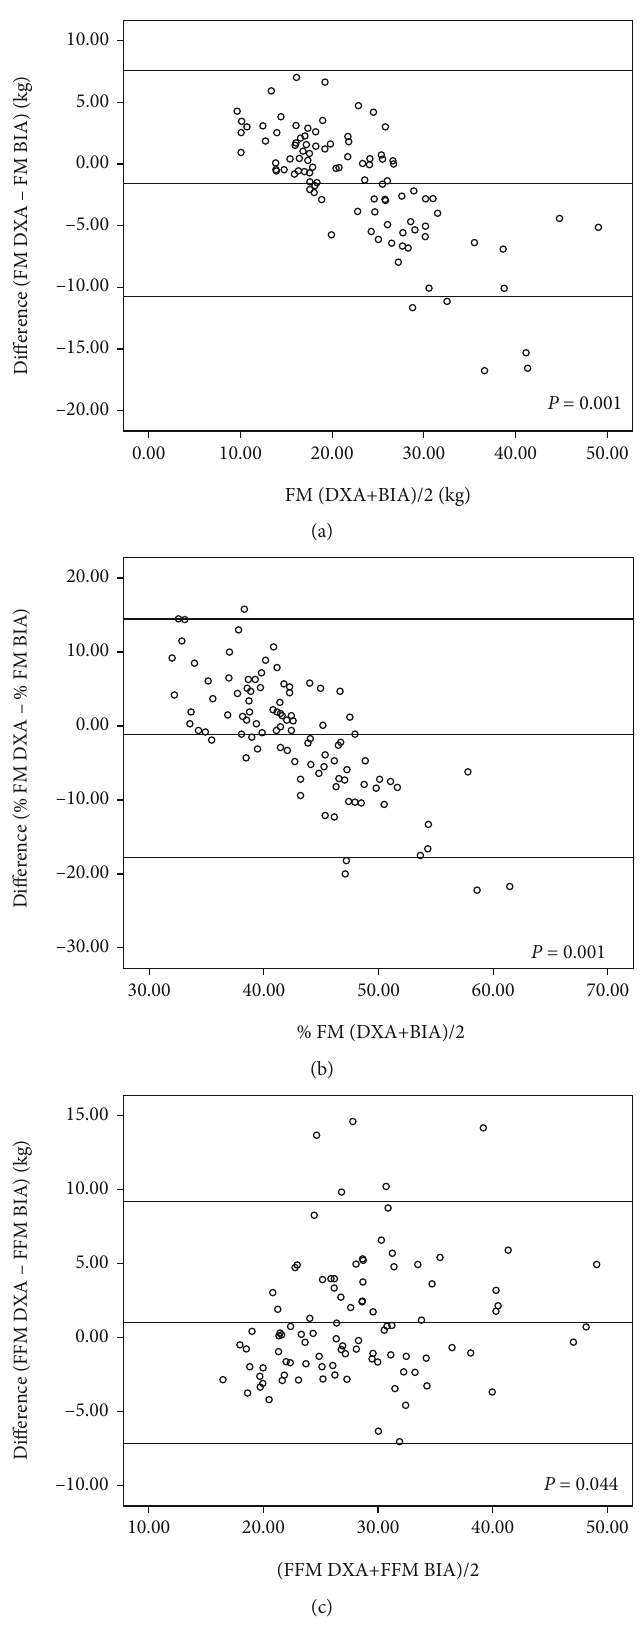
Figure 2: Bland-Altman plots comparing the accuracy of BIA in measuring fat mass (a), percentage fat mass (b), and fat-free mass (c) The middle solid line represents the mean di ff erence between DXA and BIA, and the upper and lower lines represent 95% limits of